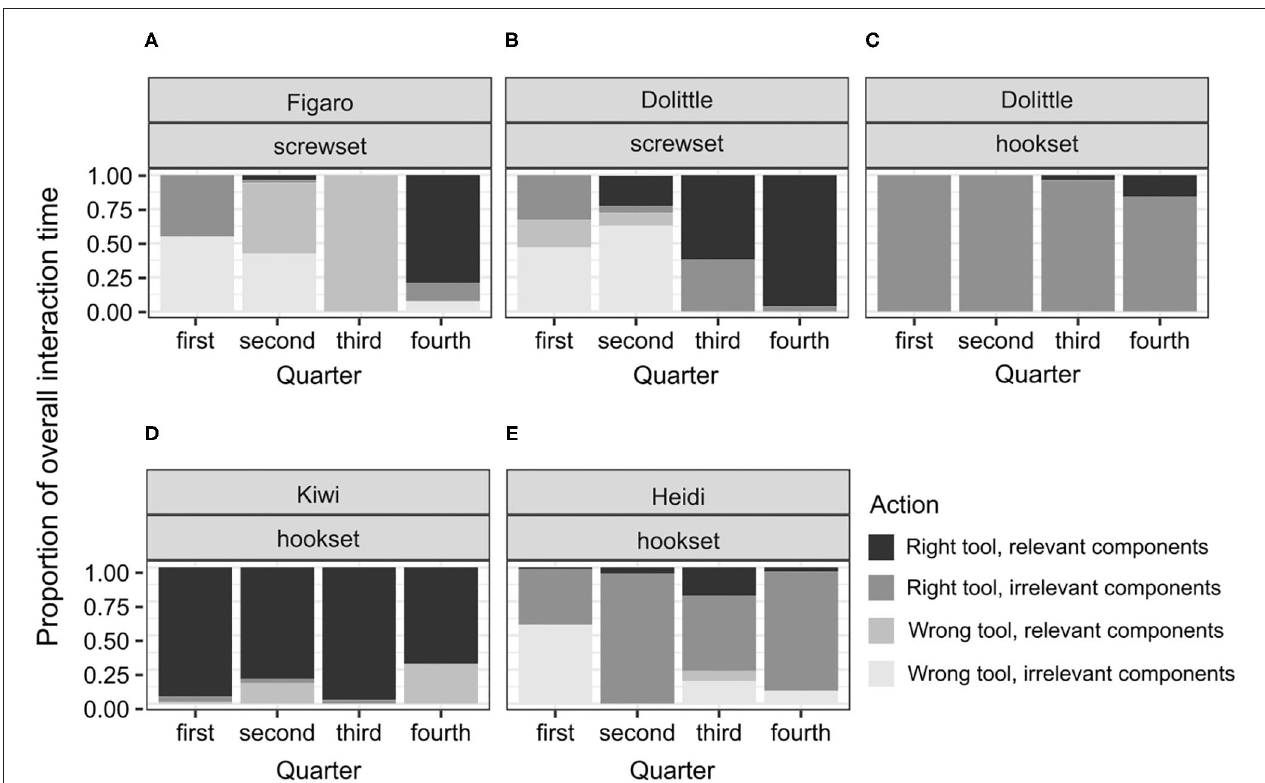
FIGURE 6 | A plot of the proportions of individual interaction times to the overall interaction time throughout the test in the conflict condition in successful subjects (A,B) , and unsuccessful subjects (C–E) . This display is based on the observed proportions.